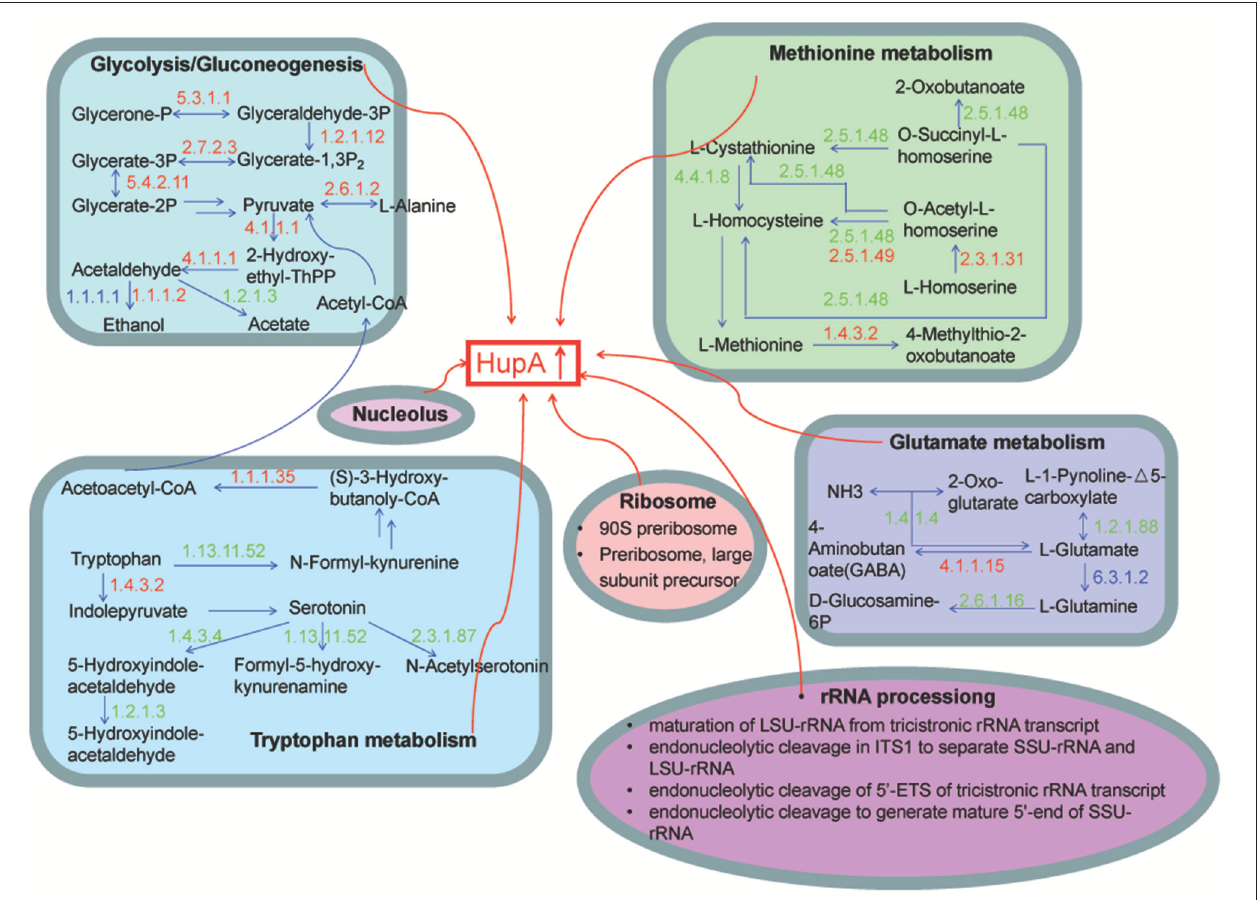
FIGURE 8 | Model illustrating the KEGG pathways and GO function clusters of the potential DEGs involved in HupA biosynthesis. The number above each horizontal arrow is the EC number of the enzyme catalyzing this reaction, while red represents upregulation, green represents downregulation, and blue represents genes that both up- and